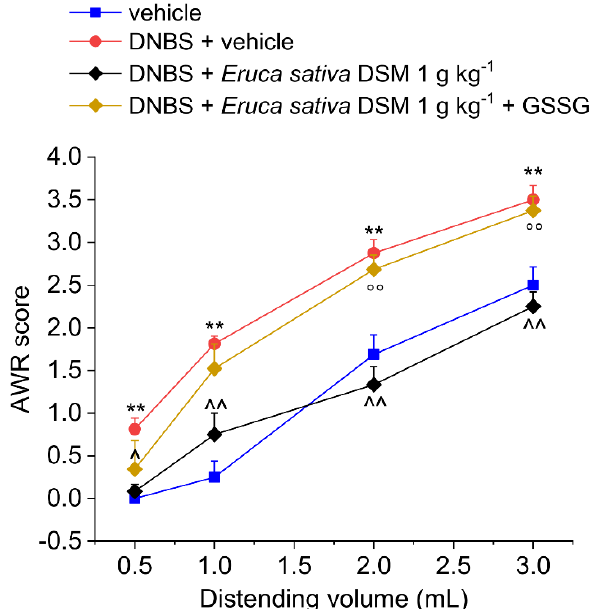
Figure 2. Role of H 2 S in the acute pain-relieving effect of Eruca sativa DSM. Visceral sensitivity was assessed in animals by measuring the extent of the abdominal withdrawal response (AWR) to colorectal distension, carried out by applying an increasing distending stimulus on the colon walls (0.5–3 mL). Oxidized glutathione (GSSG) (20 mg kg − 1 ) was orally administered in concomitance with Eruca sativa DSM (1 g kg − 1 ), and the test was performed after 30 min. Each value represents the mean ± SEM of six animals per group. ** p < 0.01 vs. vehicle. ˆ p < 0.05 and ˆˆ p < 0.01 vs. DNBS + vehicle. ◦◦ p < 0.01 vs. DNBS + Eruca sativa DSM.